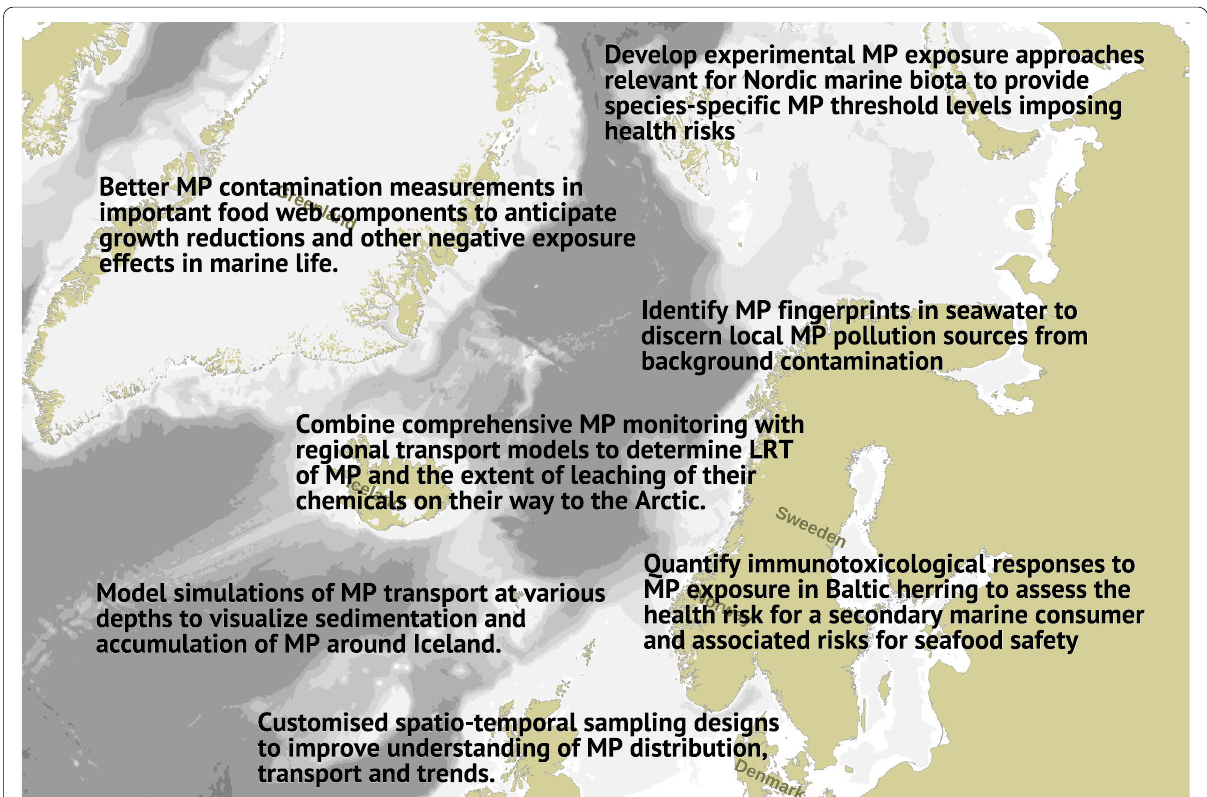
Fig. 3 Key suggestions regarding MP research needs in the Nordic marine